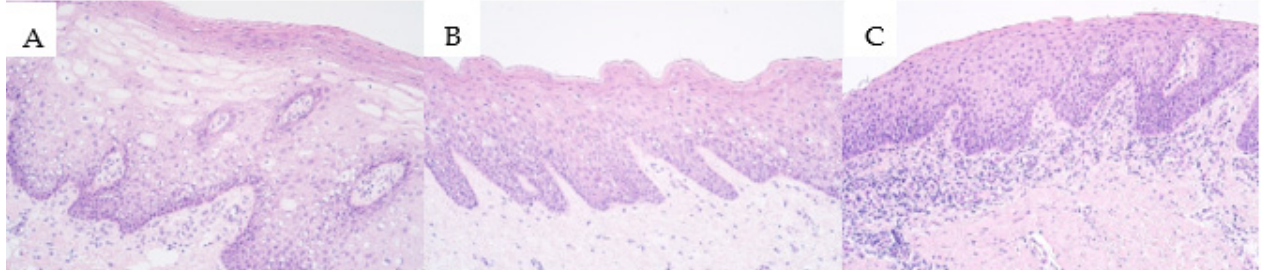
Figure 1. Micrographs of cleft affected tissue stained with hematoxylin and eosin (H&E). ( A ) Unilateral cleft lip affected tissue with visible vacuolization within the oral epithelium, hematoxylin and eosin (H&E), 200×. ( B ) Bilateral cleft lip affected tissue with some patchy vacuolization within the epithelium, H&E, 200x. ( C ) Isolated cleft palate affected tissue with visible subepithelial inflammation, H&E, 200×.